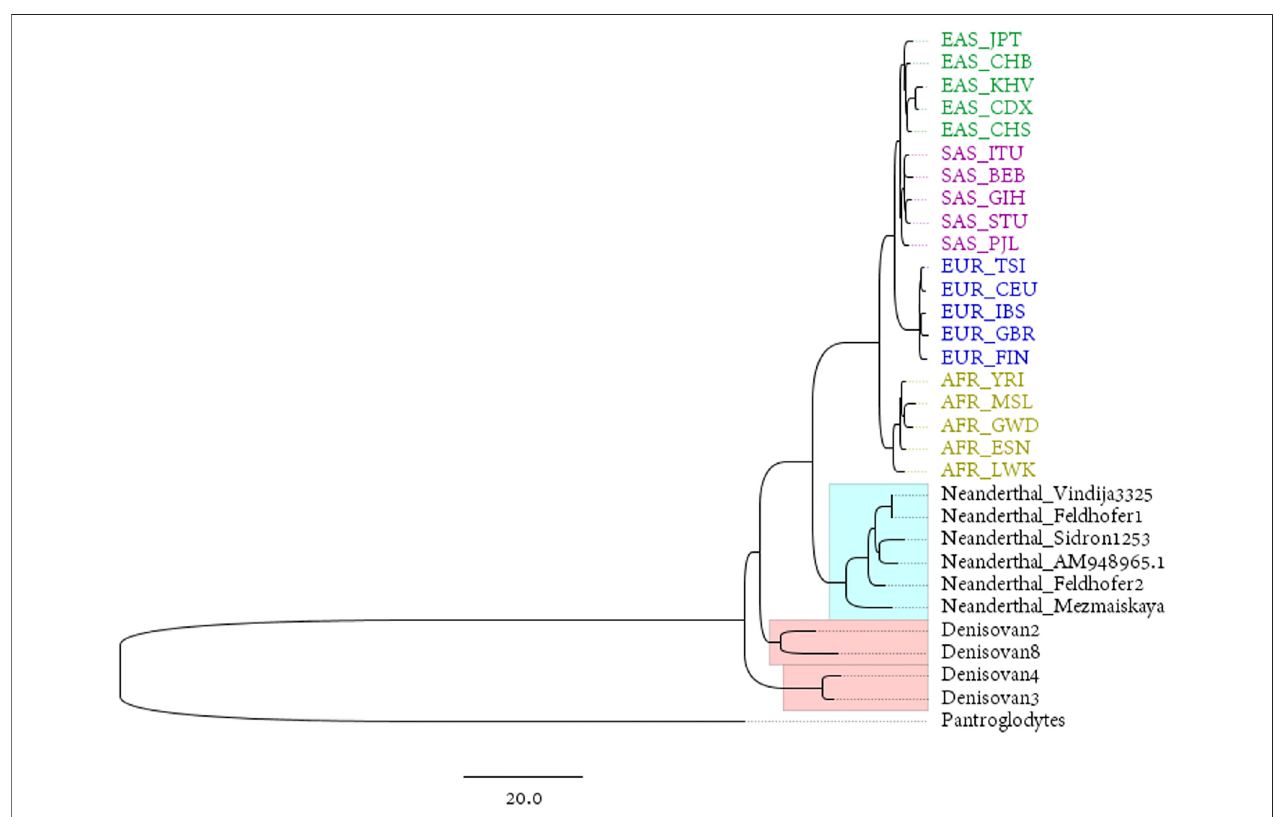
FIGURE 3 | BIONJ tree based on the distance matrix obtained with the DNV method from the mitochondrial data of 20 modern populations from 1,000 Genomes Project and 10 ancient hominins (with Pan troglodytes as the outgroup).